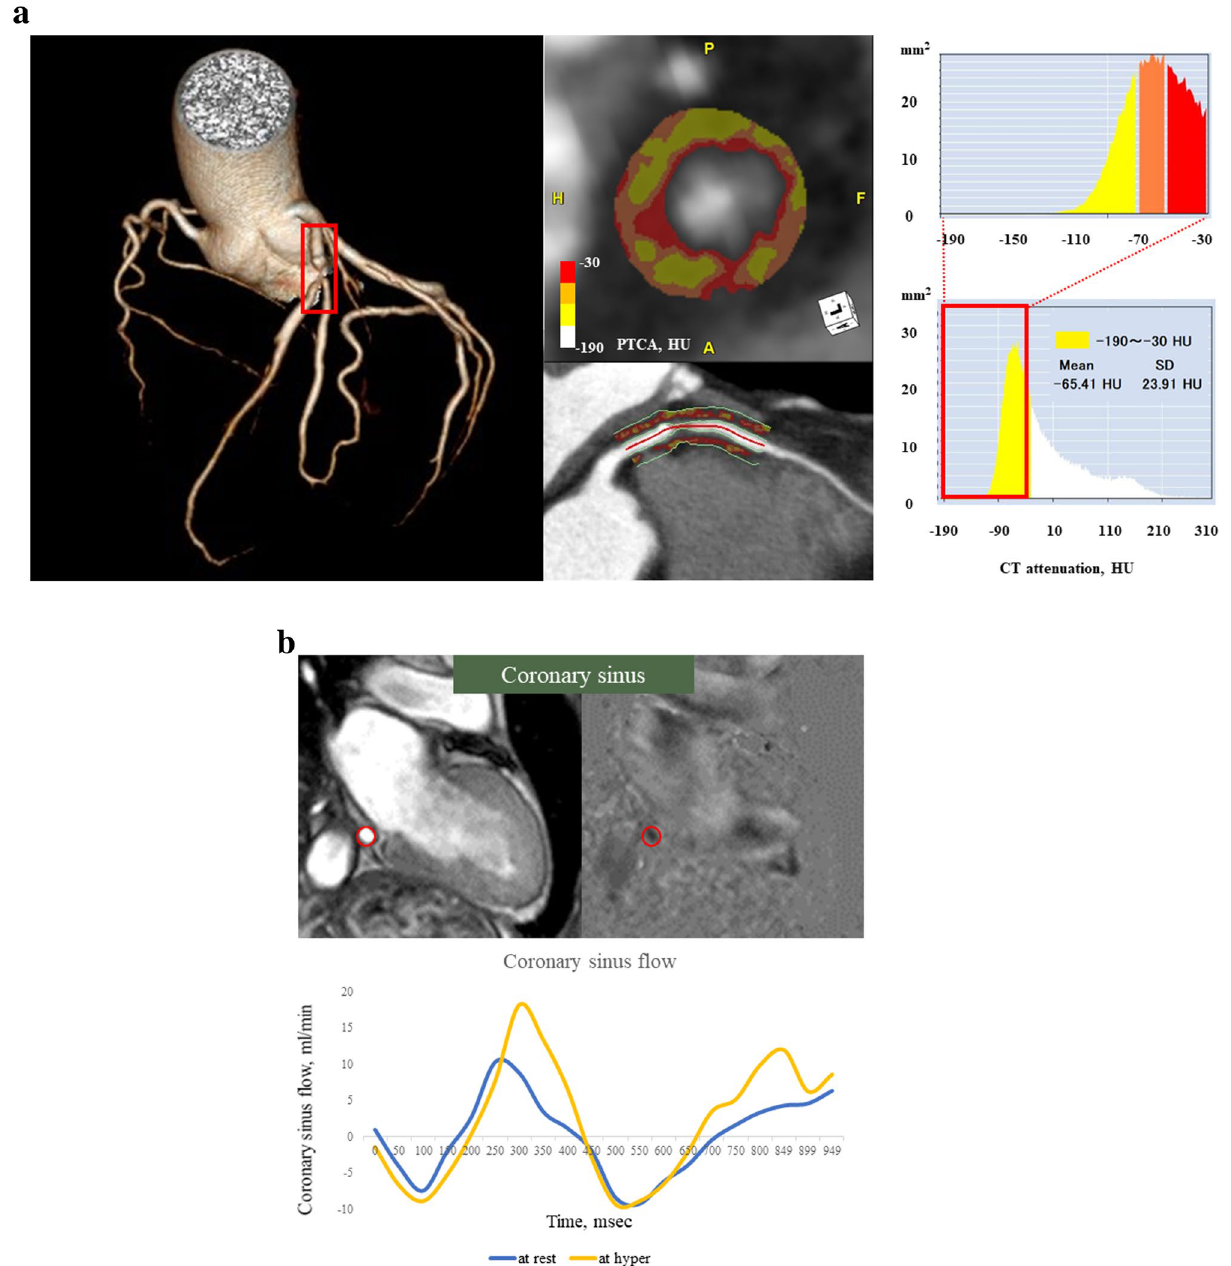
Figure 2. Representative case images. ( a ) Coronary computed tomography angiography image of pericoronary adipose tissue attenuation and a representative coronary sinus flow measurement. Pericoronary adipose tissue attenuation is defined as the mean CT attenuation value (− 190 to − 30 Hounsfield units [HU]) within a radial distance equal to the diameter of the vessel. ( b ) Phase-contrast cine-magnetic resonance images of the coronary sinus flow measurement. The proximal coronary sinus was detected in cross-section on the magnitude and phase-contrast images. The coronary sinus blood flow curves (Blue line: resting flow; Yellow line; hyperemic flow) were